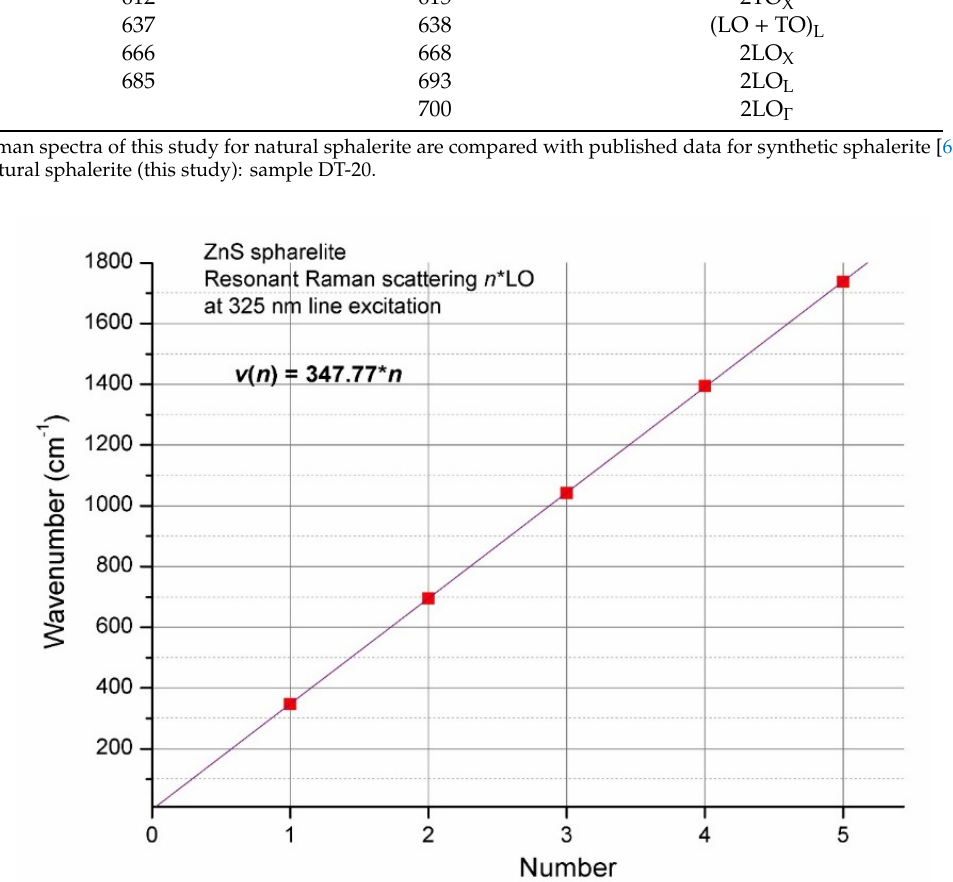
Sphalerite (cubic) and würtzite (hexagonal) ZnS polymorphs have only a minor enthalpy difference (from 2 to 13 kJ mol − 1 at ambient conditions). This small difference alone cannot account for greater stability of the zinc blende structural type and its wide spread in both natural and synthetic ZnS systems, given that the würtzite type is more stable in the case of CdS [65]. In the latter publication, the stability of the two structure types was explained proceeding from the respective interatomic potentials of ZnS and CdS and from their ability to reproduce many properties of sphalerite, würtzite, greenockite, and hawleyite (CdS cub ). The same approach can be useful to